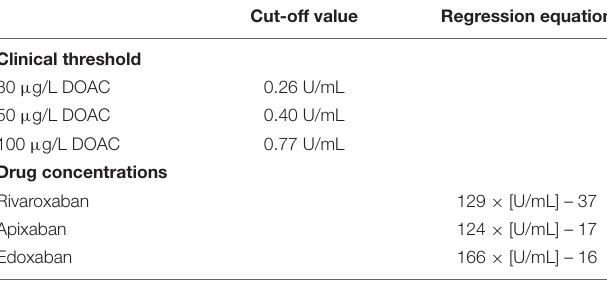
TABLE 3 | Implementation of a single, heparin-calibrated anti-Xa assay for the measurement of rivaroxaban, apixaban, and edoxaban drug